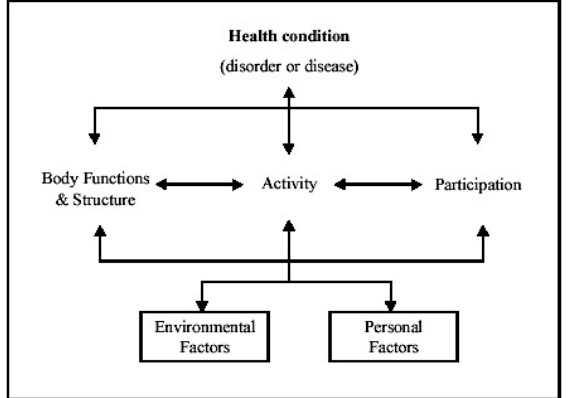
Figure 2. International Classification of Functioning (World Health Organization,